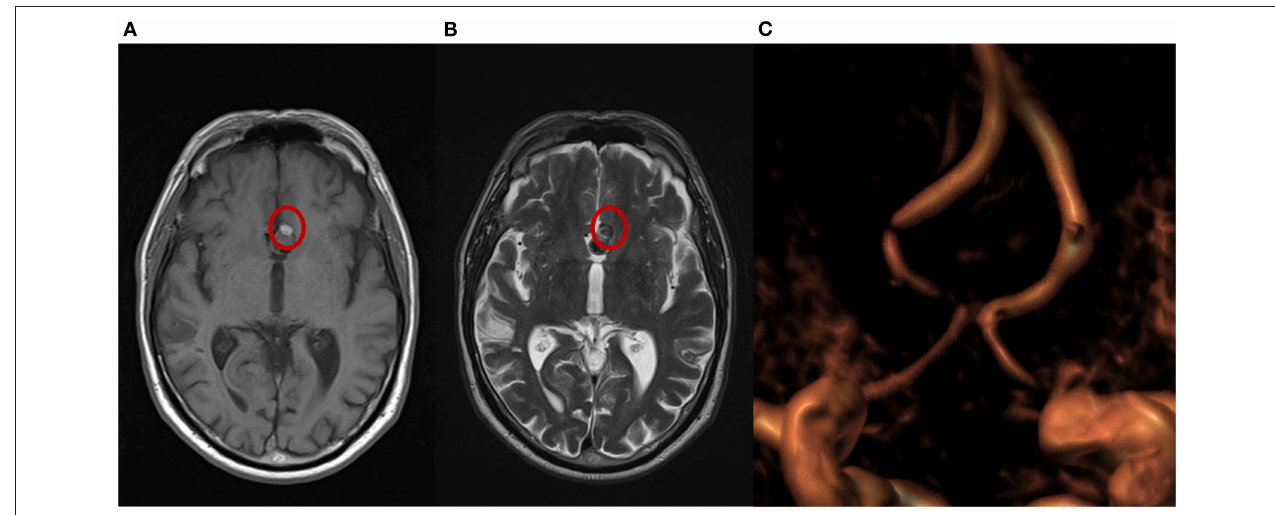
FIGURE 3 | Magnetic resonance imaging (MRI) from a patient with complete occlusion at 3-month follow-up. (A) T1 weighted spin echo (T1W SE); a small portion of hyperintensity can be visualized at the bottom of the aneurysm. (B) T2 weighted turbo spin echo (T2W TSE); a small portion of isointensity in the same area shows a different grade of cloth maturation in the thrombosis process occurring in the sac after the treatment. (C) A 3-dimensional time of flight (TOF 3D) volume rendering image shows no flow in the aneurysm.